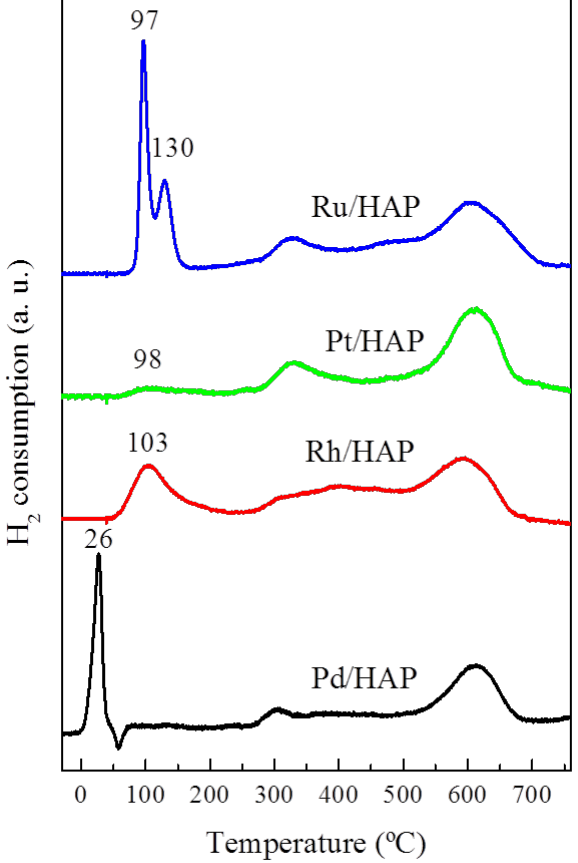
Figure 3. H 2 -TPR diagrams for the noble metal catalysts.